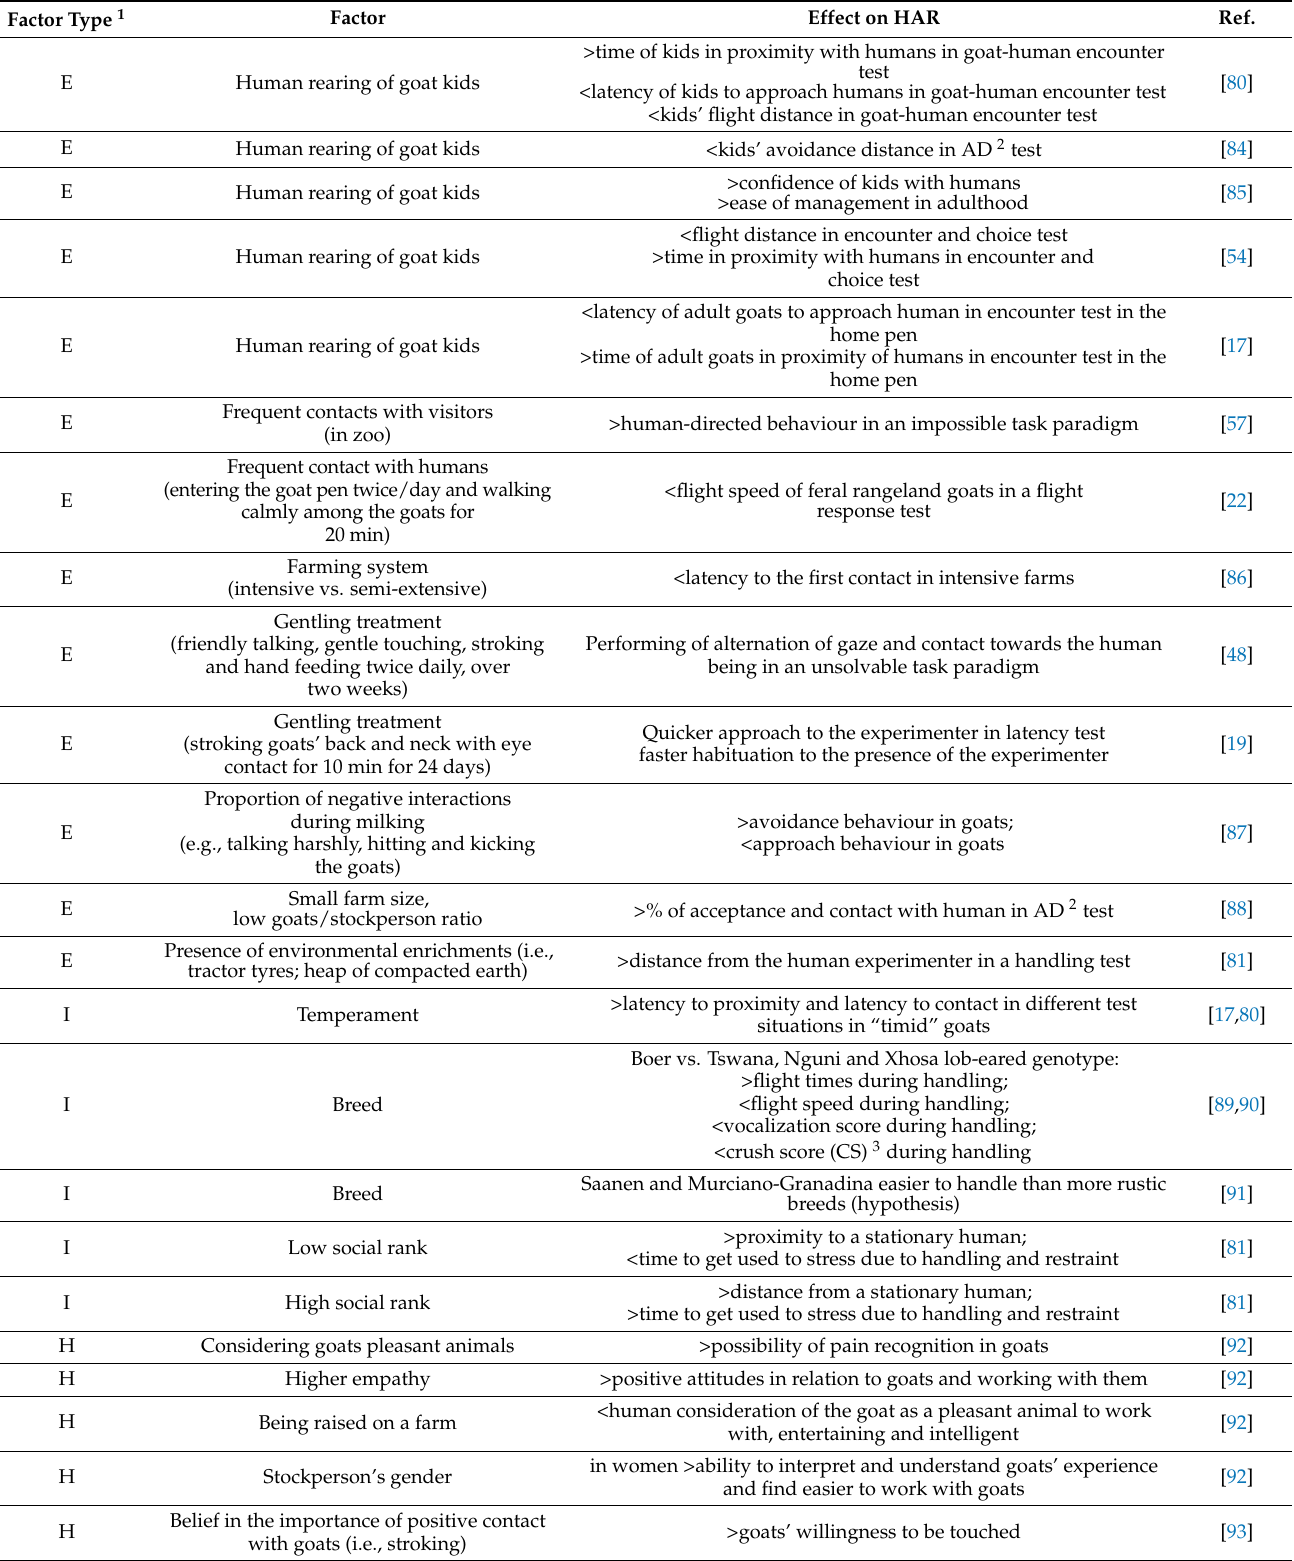
Table 2. Factors affecting the human–goat